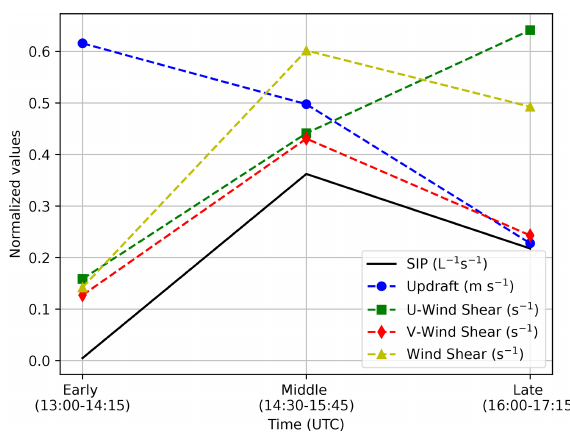
Figure 11. Normalized median values of the PDFs of the variables in Table 2 for the three different time periods for the BR2.8T simu- lation.